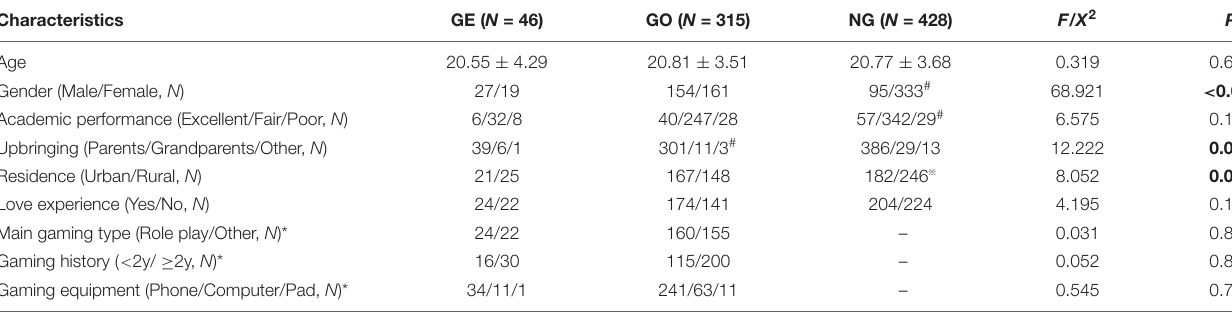
FIGURE 3 | Design of mental rotation task. TABLE 1 | Association of the general characteristics with gaming experiences and